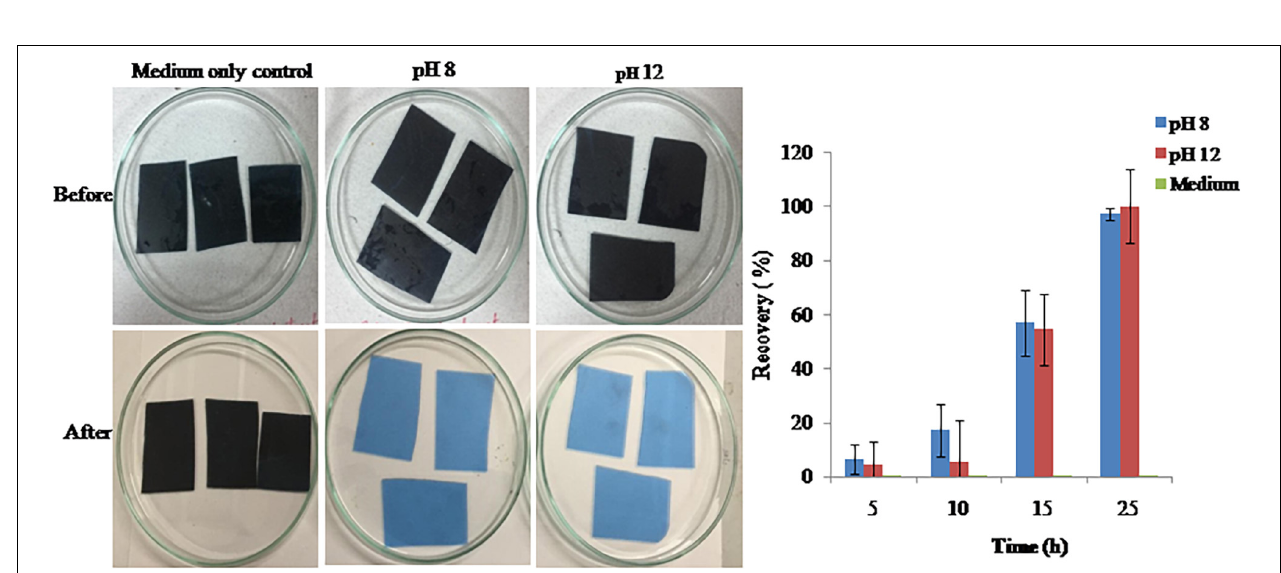
FIGURE 6 | Wash performance analysis of PyCP. Visual observation of stains before and after washing and % stain removal after PyCP treatment is shown. Same letters on the bars represent no significant difference from each other.